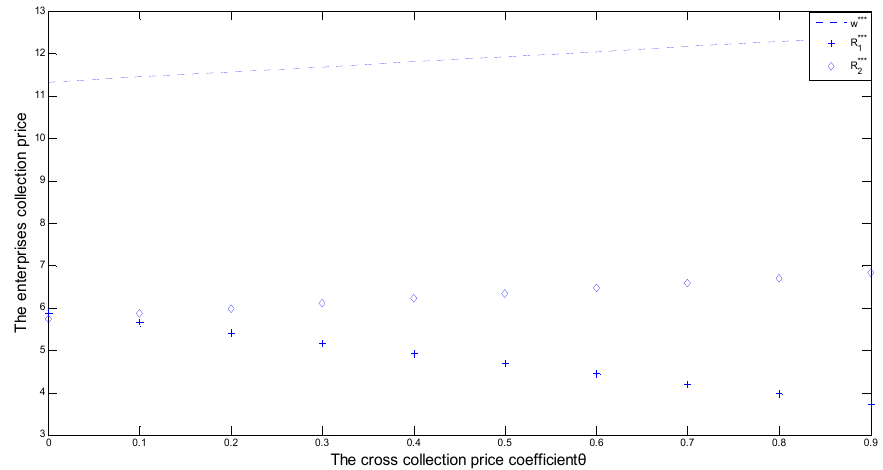
Figure 3. The impact of the cross collection price coefficient θ on the collection price w ∗∗∗ R ∗∗∗ and R ∗∗∗ . 1